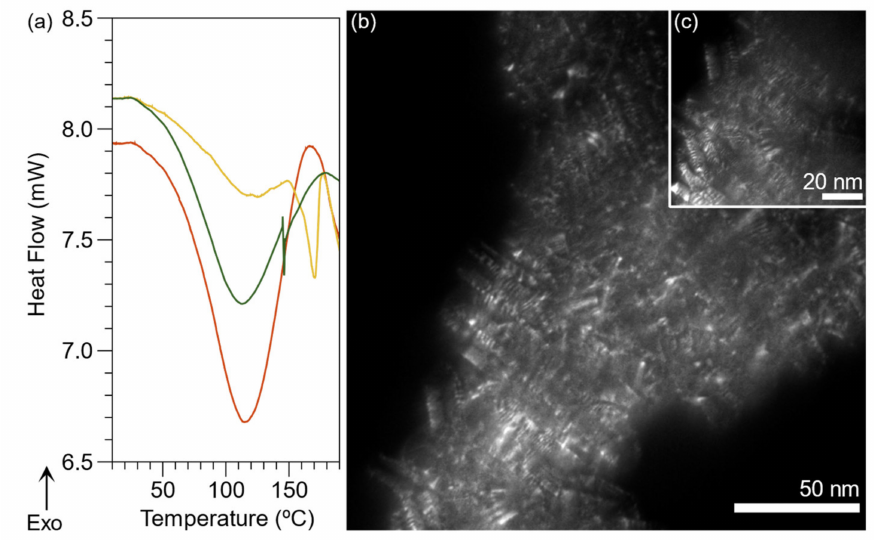
Figure 10. ( a ) DSC thermogram of macro-RAFT (red); PAAMP- b -PVK (yellow); BL PAni (green). ( b , c ) TEM micrograph of BL